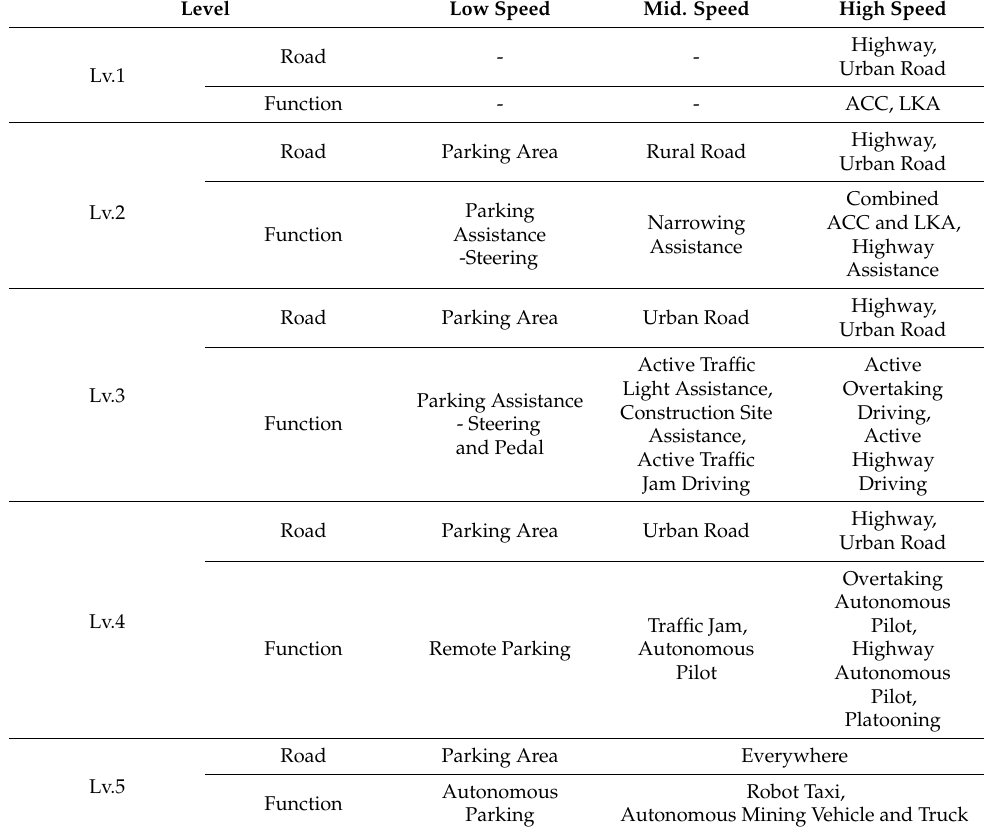
Table 8. Scenario